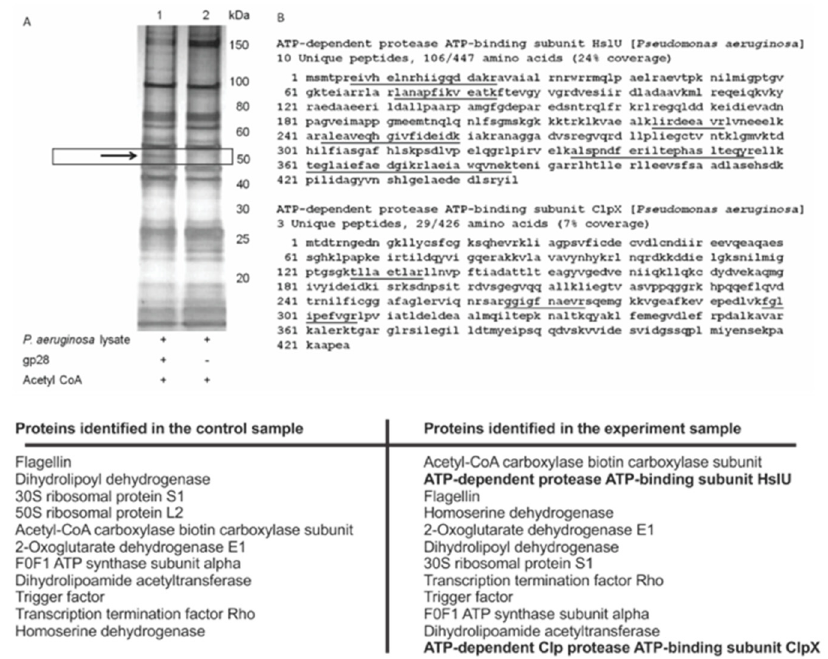
Figure A5. Analysis of Rac induction in Tn-mediated single-gene knockouts of P. aeruginosa PAO1. All predicted cytoplasmic proteases in the genome of P. aeruginosa were selected and transformed with the pUC18mini- Rac construct, which allows stable, single-copy expression of the phage Gcn5-related acetyltransferase (GNAT). The resulting strains were plated on media with and without the presence of 1 mM IPTG, and checked for overnight growth in comparison to the wildtype strain.